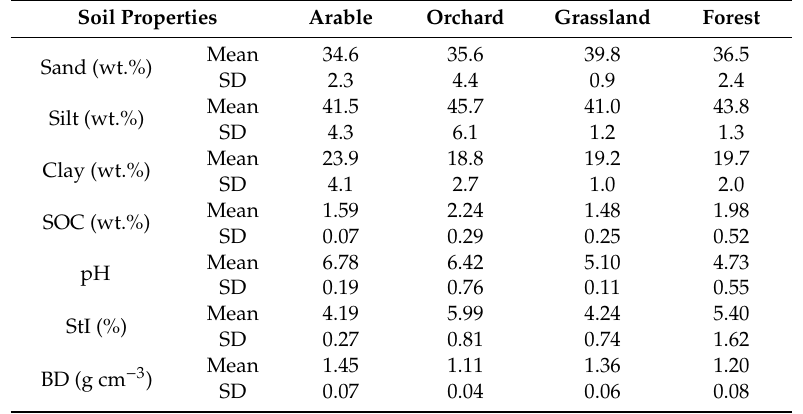
Table 1. The mean and standard deviation (SD) of soil properties at the four research